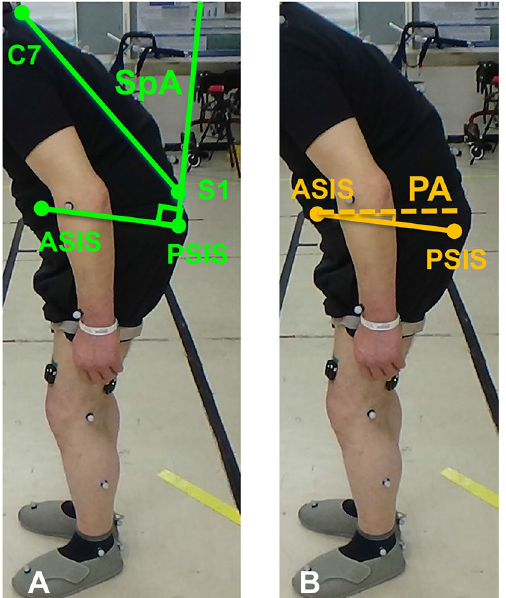
Figure 3. Measurement of dynamic spino-pelvic sagittal balance during gait from the three-dimensional motion analysis. ( A ) The sagittal spinal angle (SpA) is the sagittal angle between the line connecting the reflective markers on the C7 and S1 spinous process and the line connecting reflective markers on the anterior superior iliac spine (ASIS) and the posterior superior iliac spine (PSIS). ( B ) The sagittal pelvic angle (PA) is the sagittal angle between the horizontal axis and the line connecting the reflective markers on the ASIS and